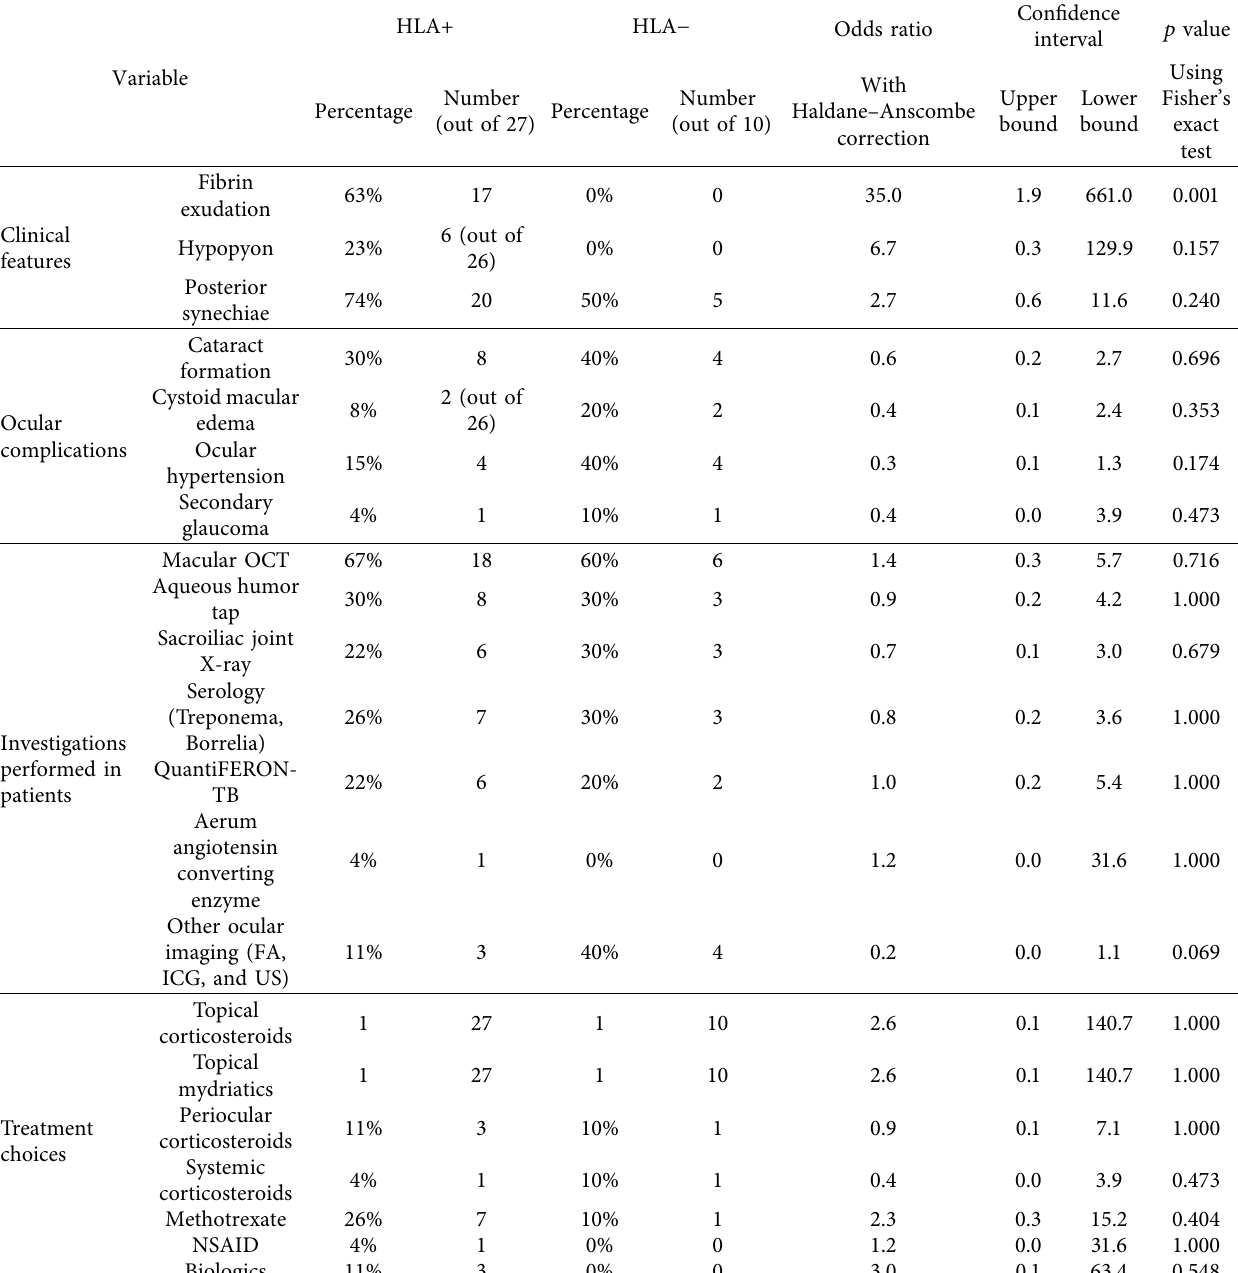
Table 2: Clinical features, ocular complications, investigations performed in patients and treatment